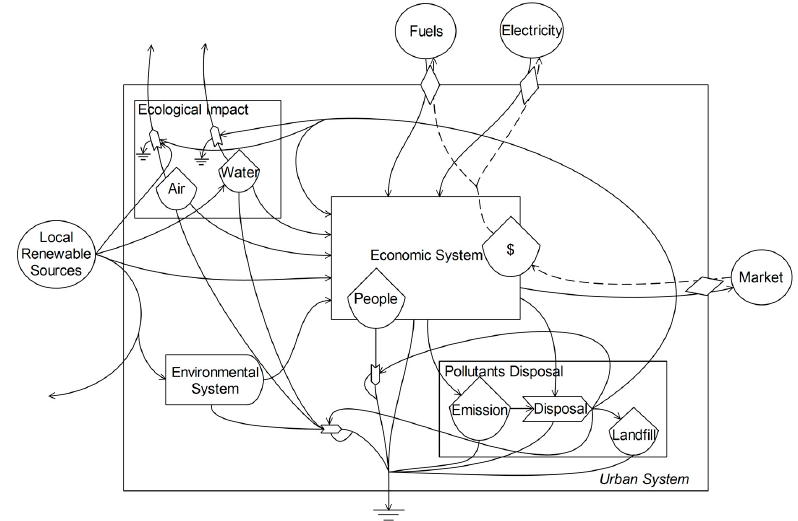
Figure 2. Diagram of the main emergy flows including emissions impact in urban system.